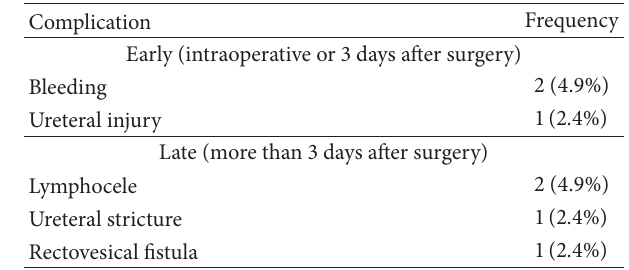
Table 2: Complications in salvage treatment ( 𝑛 = 41